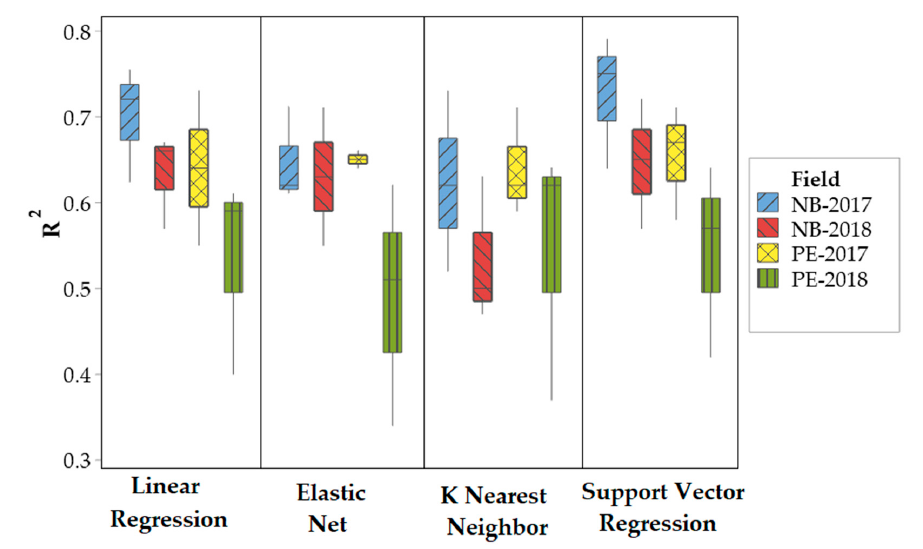
Figure 3. Comparison of the performance of machine learning algorithms for all the datasets.